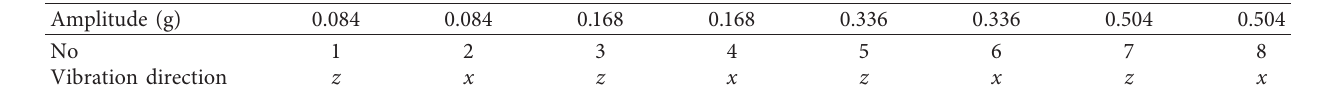
Table 3: Loading sequence of Lijiang